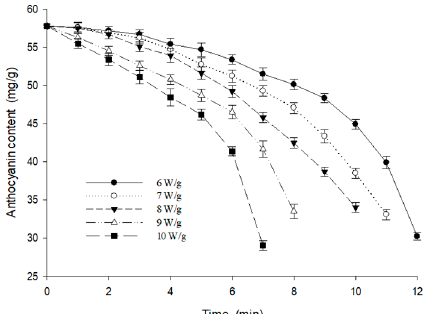
Figure 3. The characteristics of the anthocyanin content in the berry puree drying at varying microwave intensities.